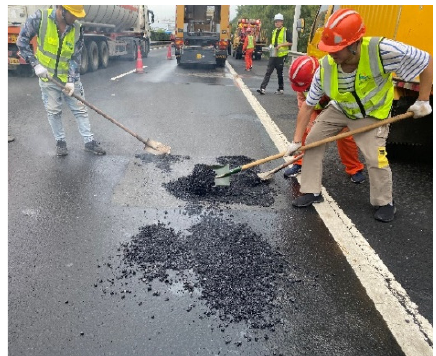
Figure 6. Manual milling hot pavement.